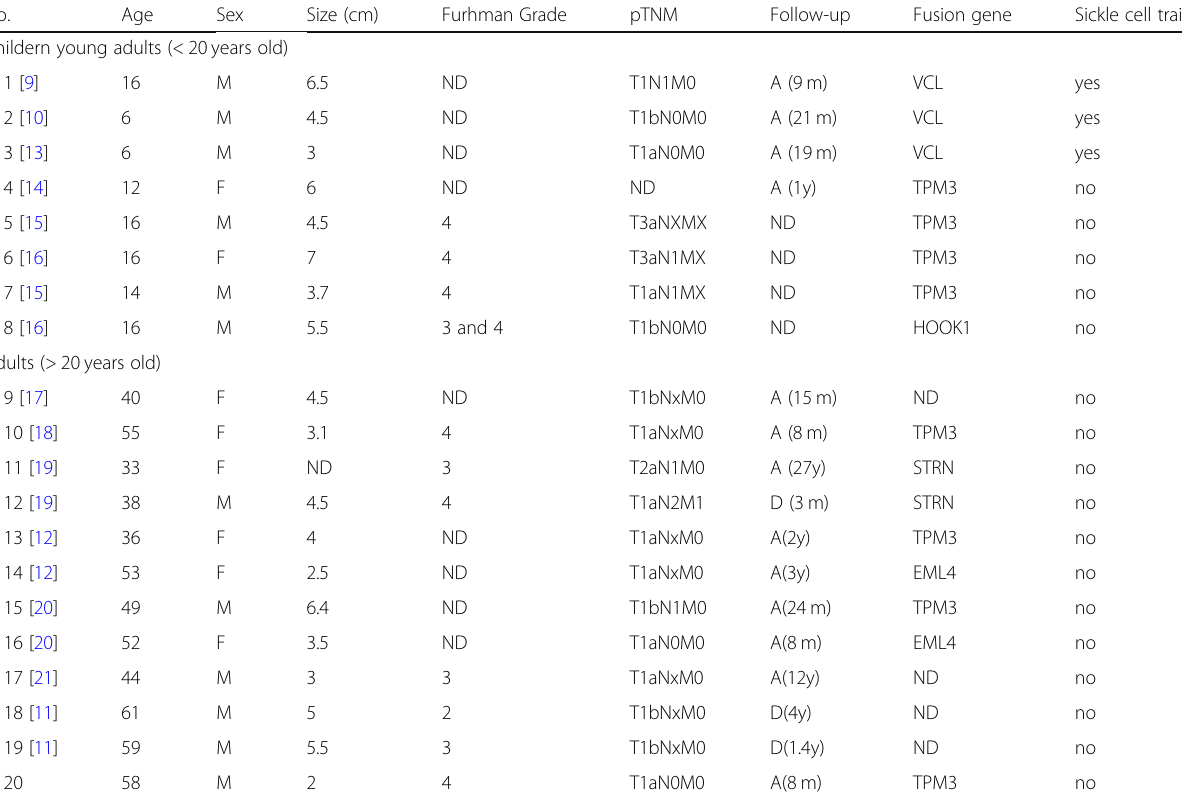
Table 1 Clinicopathological and genetic features of ALK-rearranged renal cell carcinoma in 20 cases No. Furhman Grade